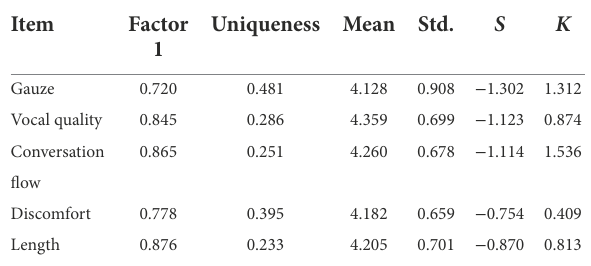
TABLE 8 Inter-rater reliability for the SSC